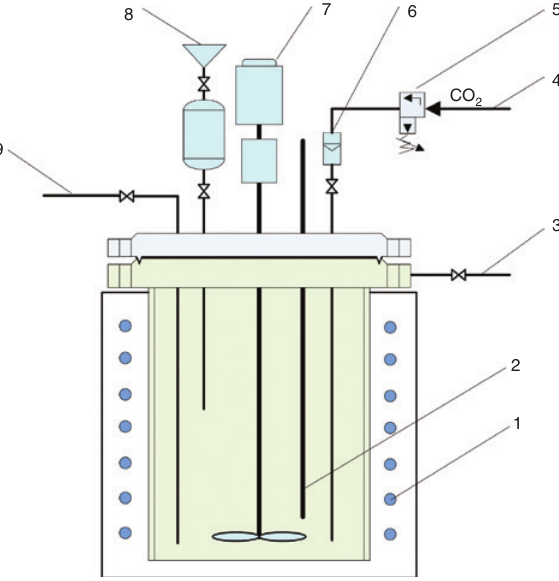
Figure 2: Schematic of the autoclave: 1, resistance wire; 2, thermocouple; 3, gas vent; 4, gas inlet; 5, pressure-release valve; 6, rotameter; 7, magnetic stirrer; 8, inflation inlet; 9, sample